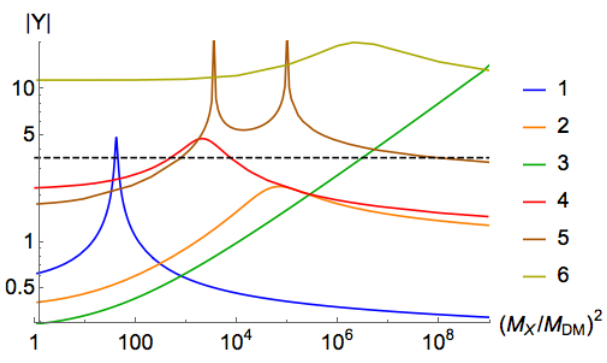
Figure 5. Absolute value of the generalized Yukawas as function of the ratio M X =M DM squared. The benchmark values are: 1. ( M S